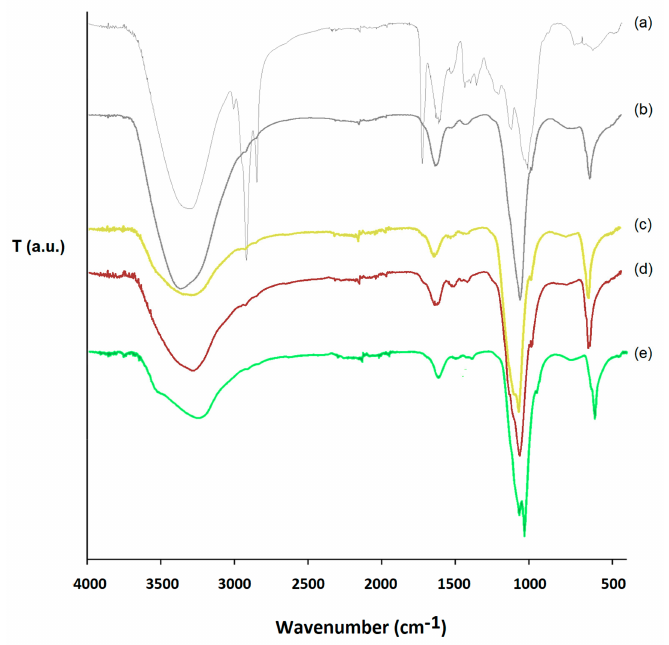
Figure 7. ATR spectra of ( a ) dried cells after recovery from culture medium (fresh diatoms) and after purification with acid-oxidative protocol of ( b ) bare, ( c ) Ir-doped, ( d ) Ru-doped, and ( e ) Al-doped shells.